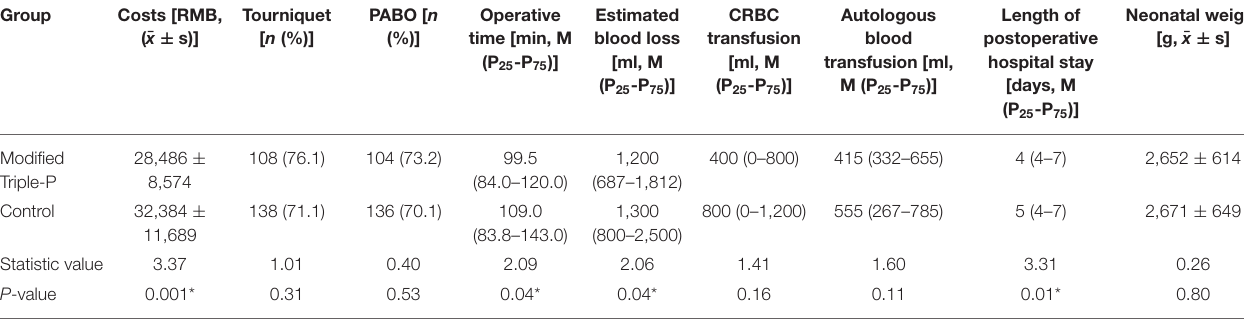
TABLE 2 | Comparation of perioperative data of the patients with placenta increta/percreta treated by two different procedures. Group